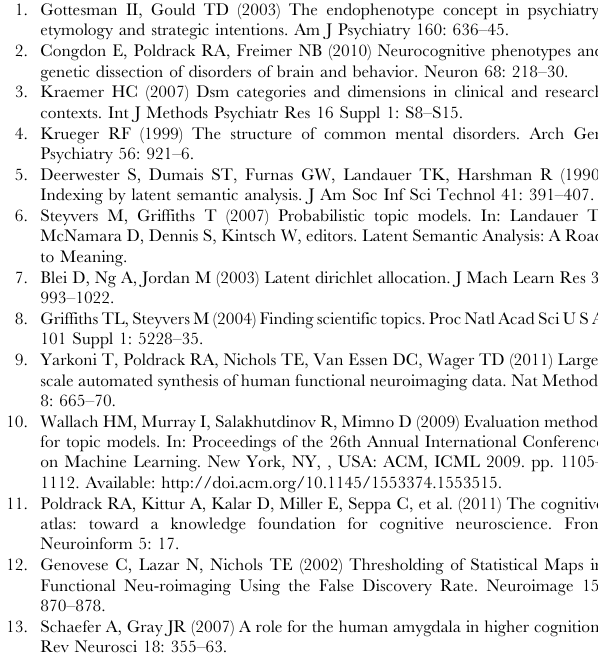
Table S1 Complete list of topics identified through application